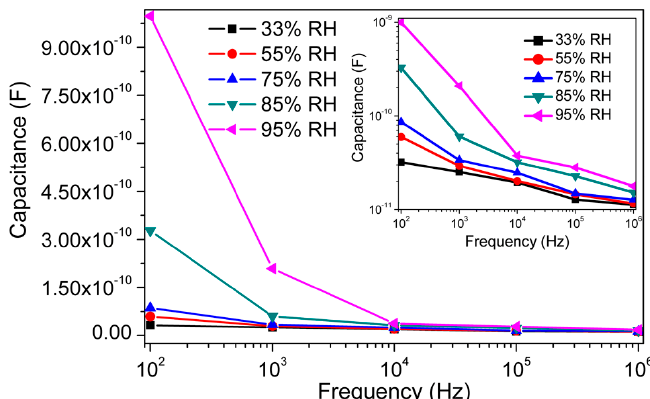
Figure 6. The variations of capacitance with frequency at different humidity condition (33%–95% RH) for CMFTO based humidity sensor at 25 °C. Inset image represents the variation of capacitance with frequency at different RH in logarithmic scale (log( C ) vs. log(RH)). Note: The value of capacitance increases with increased % RH, but decreases with increased frequency. The decreased rate is faster in lower frequency (<10 4 Hz) and higher humidity range (>85% RH).